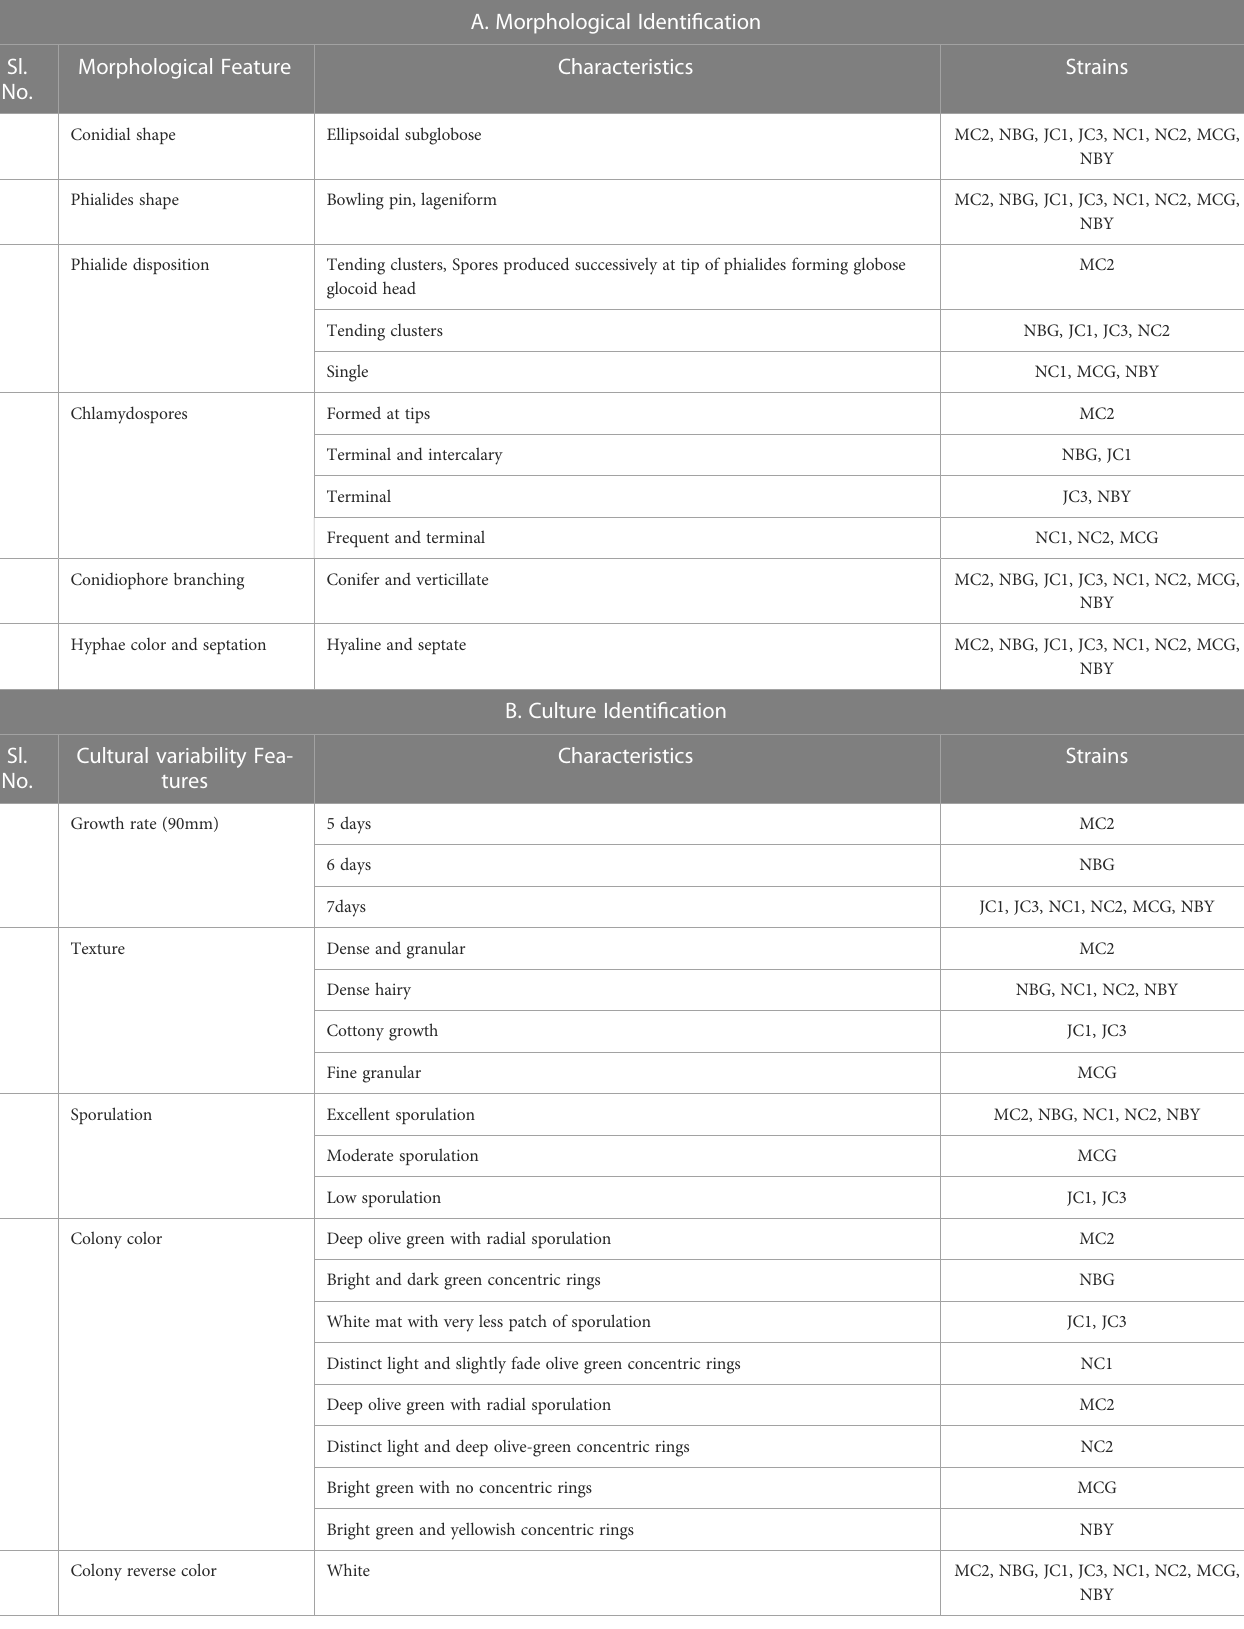
TABLE 1 Morpho-cultural characterization of the eight